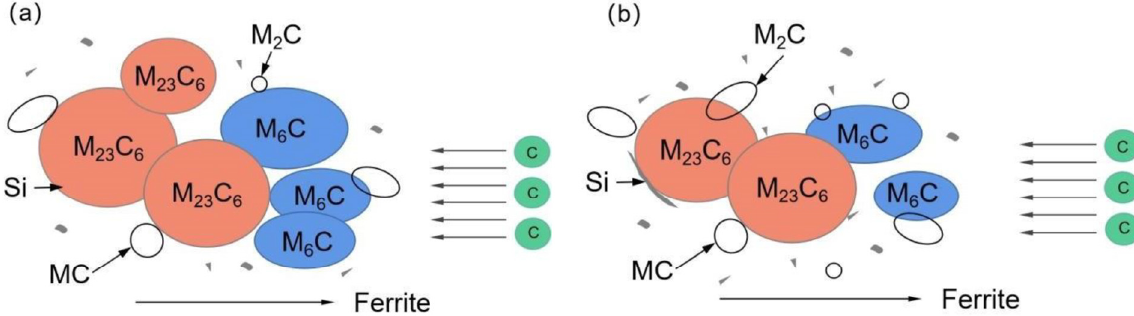
Figure 12. Carbide growth model: ( a ) 0.3 Si; ( b ) 1.0 Si.